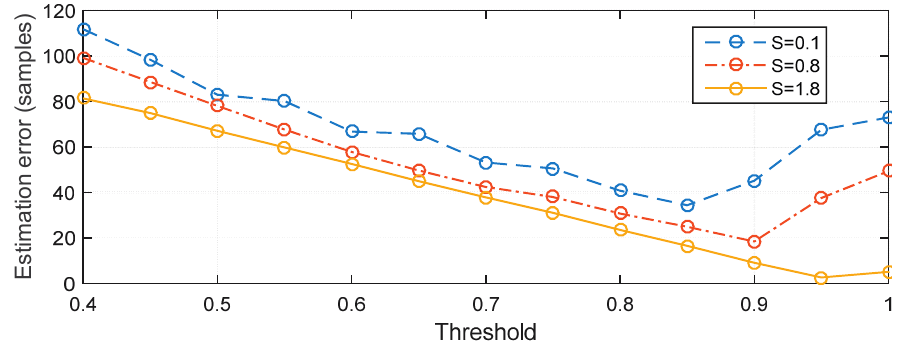
Figure 10. Relationship between MAE, threshold and skewness.